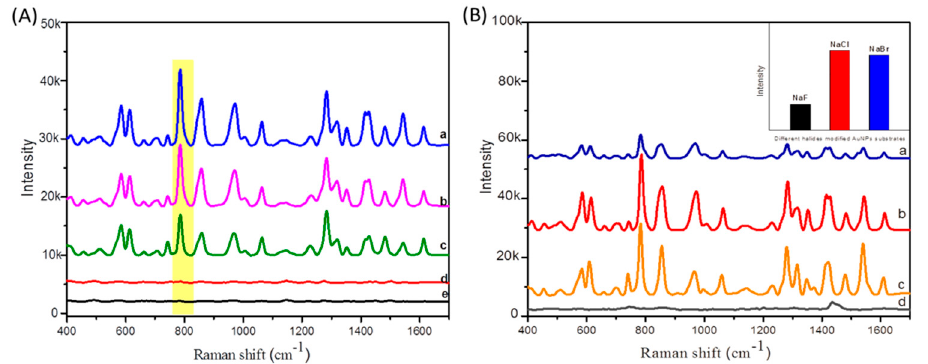
Figure 7. ( A ): SERS spectra of flumetsulam absorbed on Cl-AuNPs substrates with the addition of different sulfates (a: MgSO 4 , b: ZnSO 4 , c: Al 2 (SO 4 ) 3 , d: K 2 SO 4 , and e: (NH 4 ) 2 SO 4 ), respectively. ( B ): SERS spectra of flumetsulam absorbed on different halides-modified AuNPs substrates (a, b, c, and d represent NaF, NaCl, NaBr, and NaI respectively).